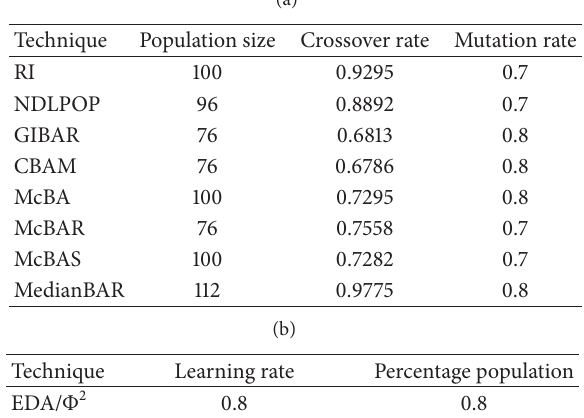
Table 6: Optimal EA